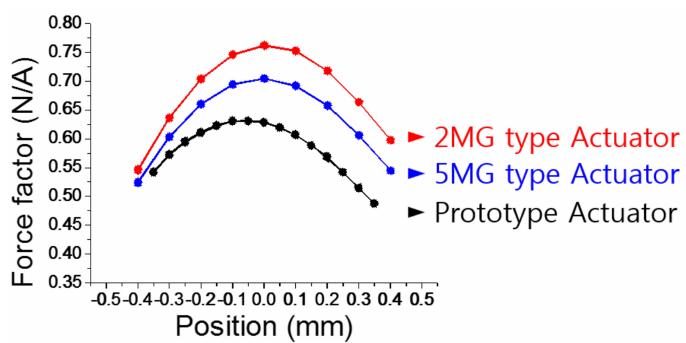
Figure 9. Force factor comparison between three